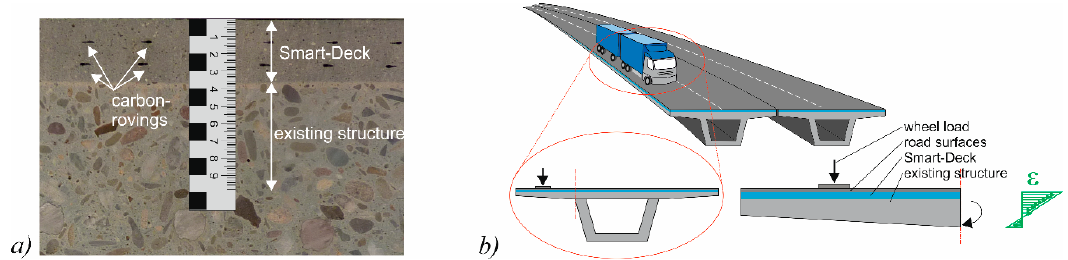
Figure 3. ( a ) Detail of a cut surface; and ( b ) a bridge loaded by a truck and the idealized load setup.